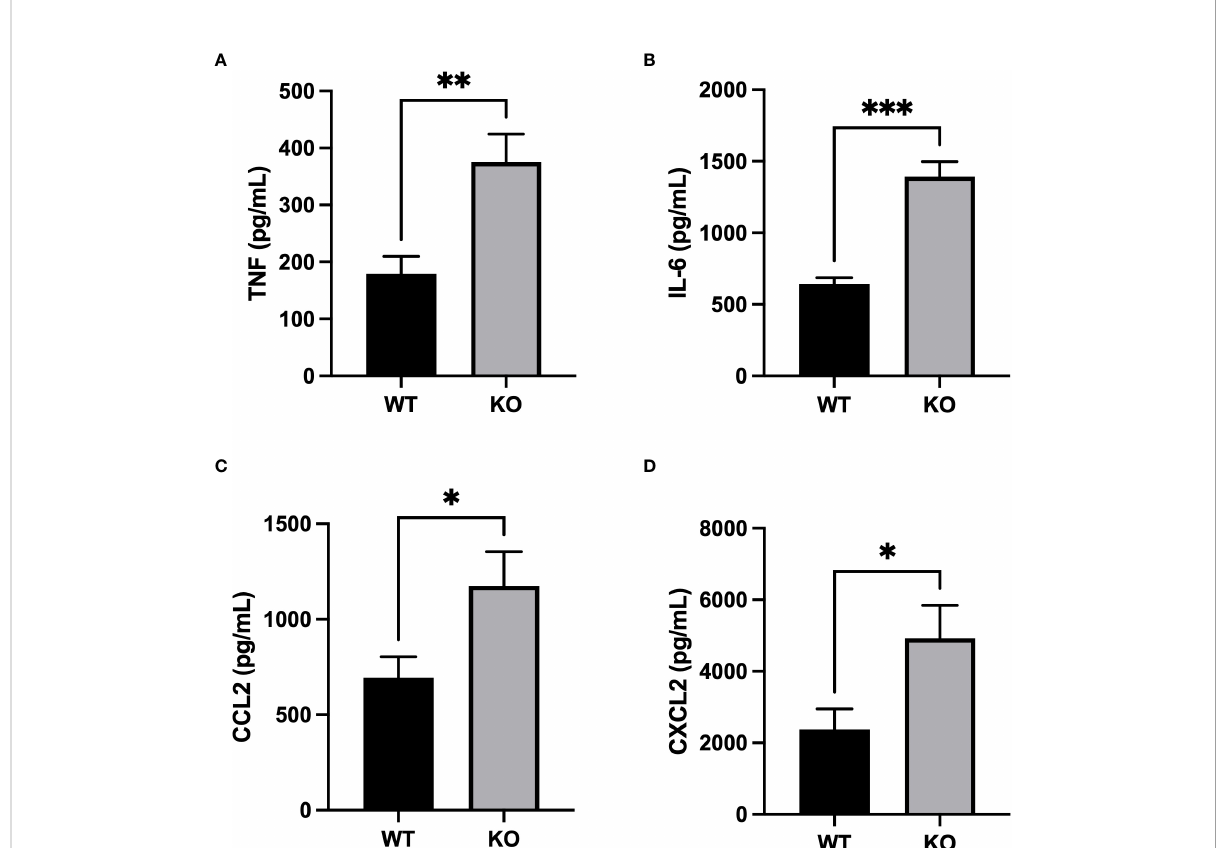
FIGURE 4 Increased production of in fl ammatory mediators in CD200 KO exposed to LPS. WT and CD200 KO rats were exposed to LPS intratracheally. In fl ammatory mediators were measured in BAL fl uid 3h post-LPS exposure by ELISA. BAL of CD200 KO rats had increased levels of (A) TNF, (B) IL-6, (C) CCL2, and (D) CXCL2. Data are from individual rats, with n = 6-8 per group of two independent experiments. Statistical signi fi cance was determined using Mann-Whitney T-Test; *P < 0.05; **P< 0.01; ***P<